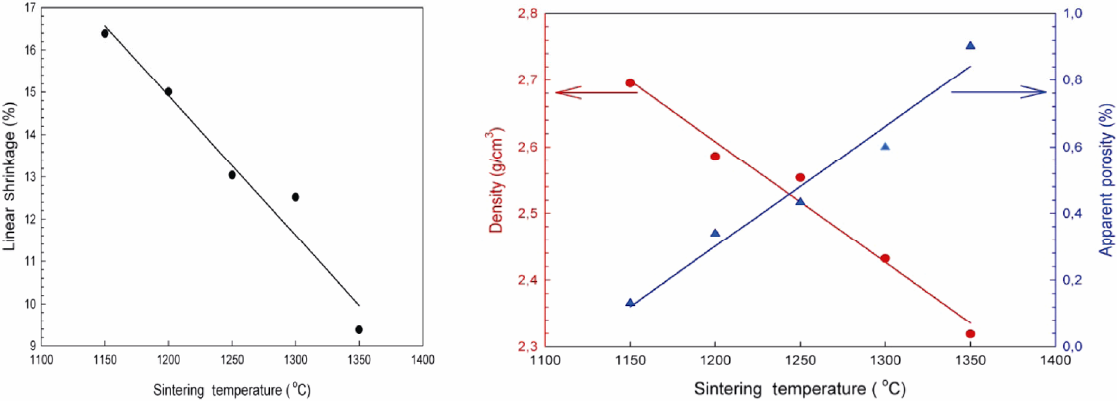
Fig. 12 (a) Linear shrinkage, (b) density and apparent porosity of sintered samples as a function of the sintering